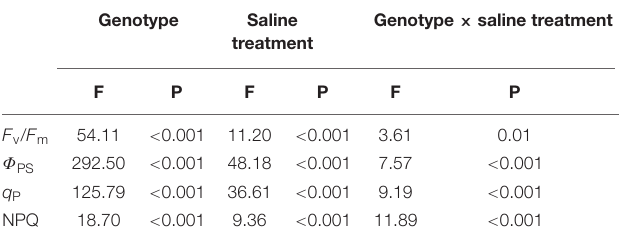
TABLE 2 | Two-way ANOVA examining the effects of genotype, saline treatment and their interaction (genotype × saline treatment) on the chlorophyll fluorescence parameters of leaves from the three P. amurensis sample